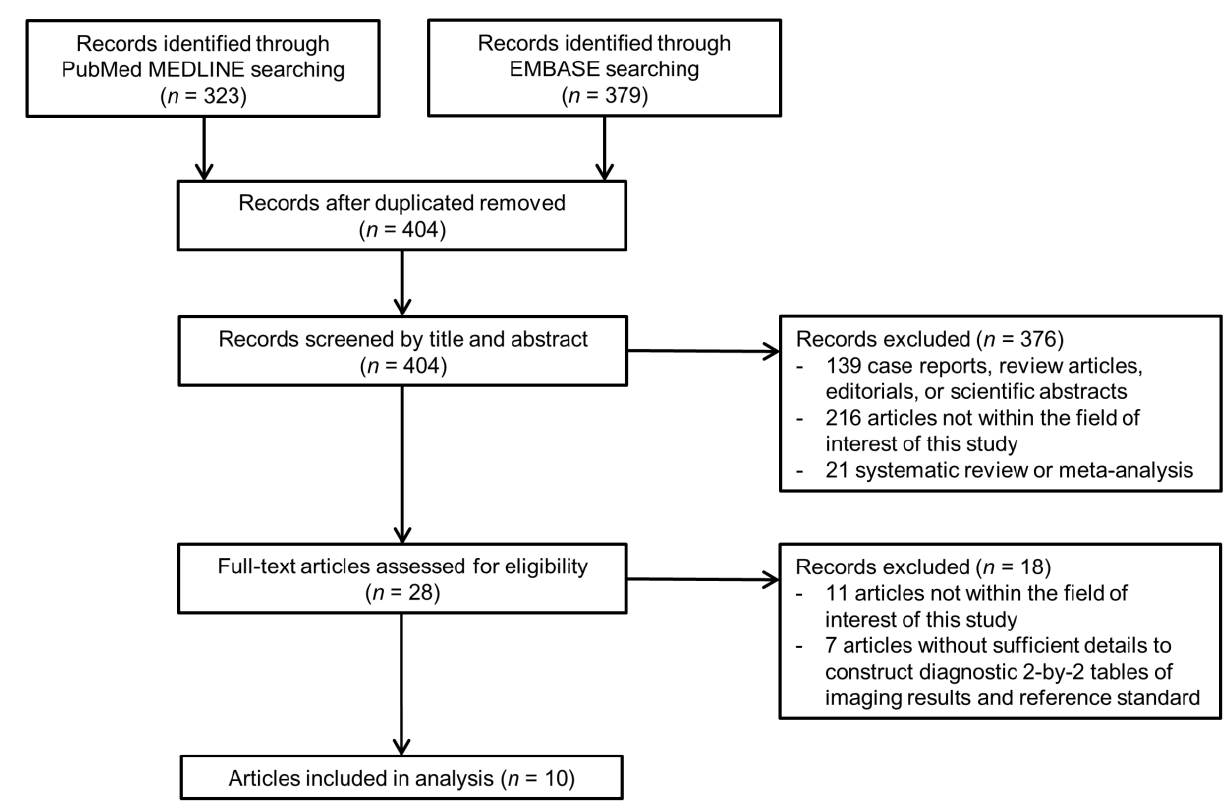
Figure 1. Flow diagram of article selection process.